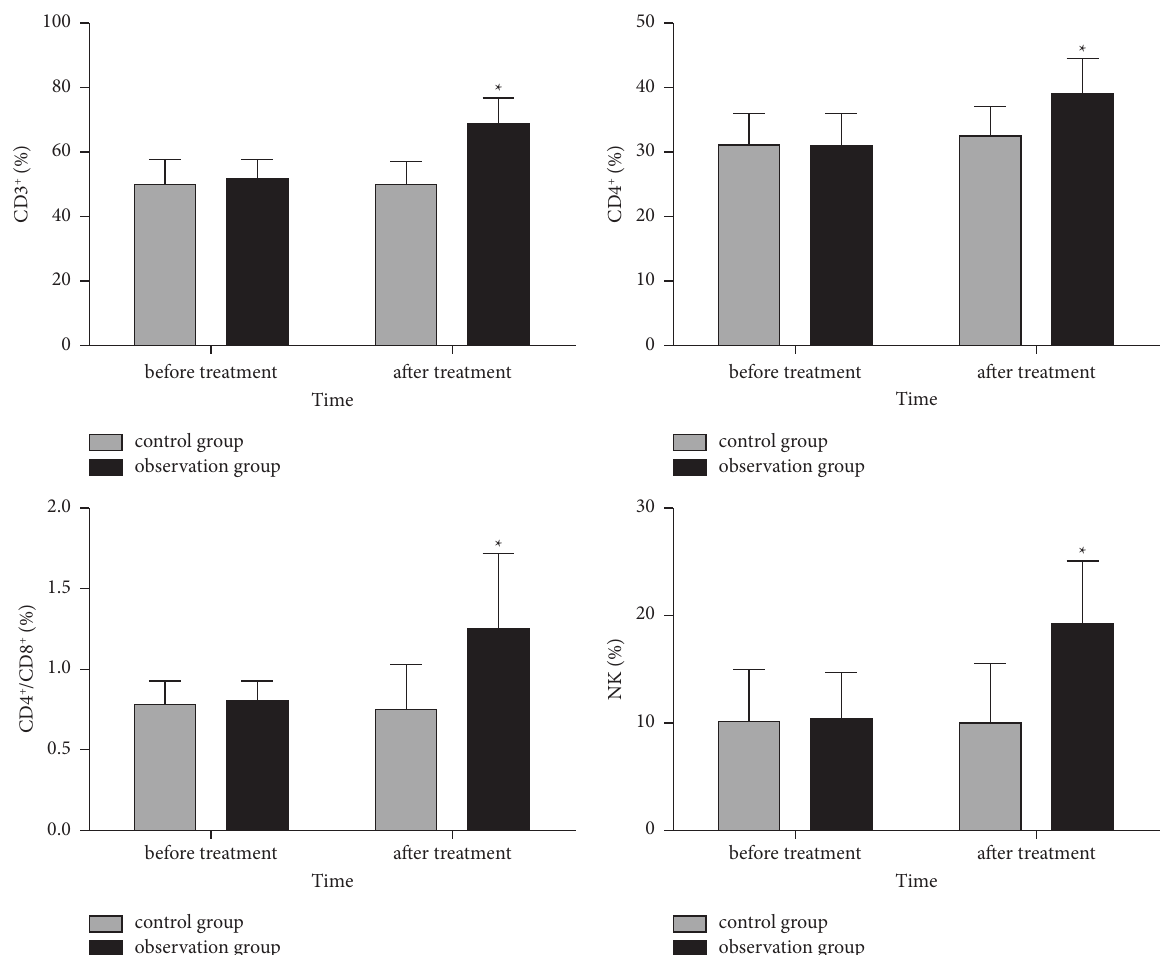
Figure 3: Comparison of immune function between the two groups before and after treatment. Note: compared with before treatment, ∗ P < 0 . 05. Table 4: Comparison of toxic and side efects of chemotherapy in two groups of patients ( n � 44, %). Nausea and Group vomiting Control group Observation